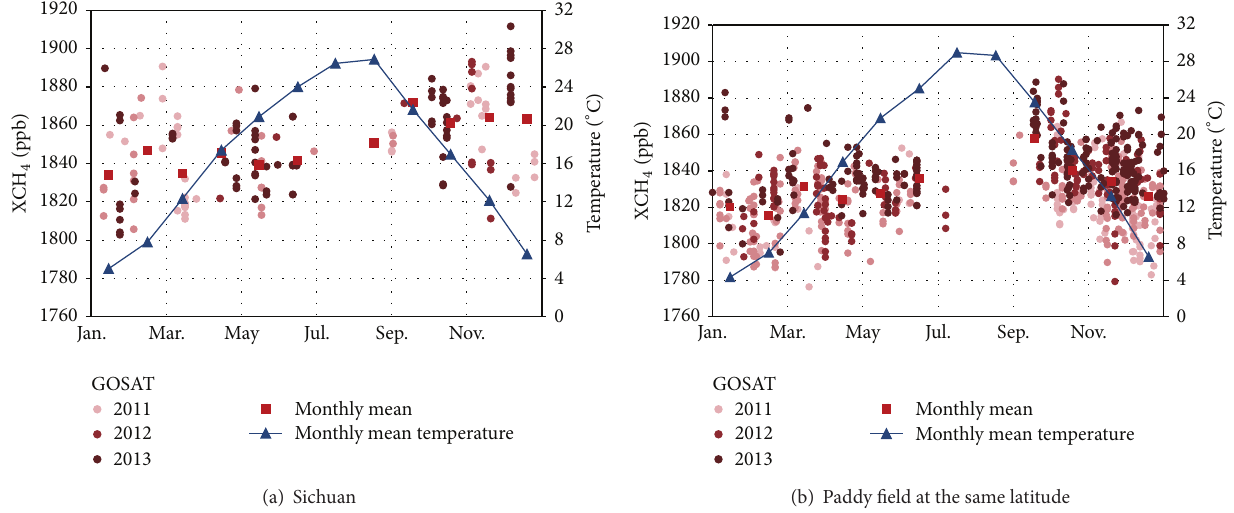
Figure 5: Comparison of XCH 4 value from GOSAT and the corresponding surface air temperature values from weather stations in (a) the Sichuan Basin and (b) the rice paddy fields in the same latitude region. The time lable of months in 𝑥 -axis indicates the beginning of each